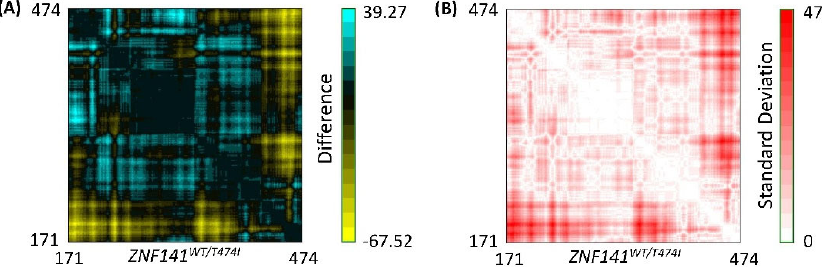
Figure 5. RR distance map comparison of wt-ZNF41 and mutant T474I. ( A ) RR distance map difference of wt-ZNF141 and mutant ZNF141 protein after simulation ( B ) Standard deviation of RR distance map of wt-ZNF141 and ZNF141T474I protein after 100 ns MD simulation.